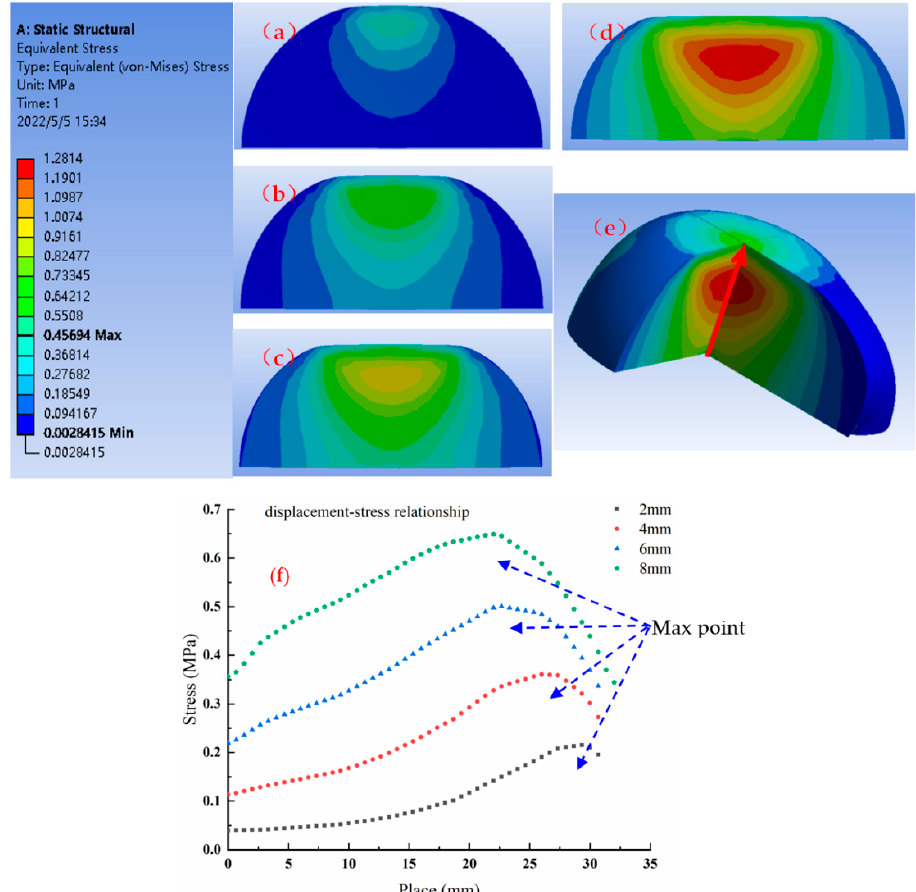
Figure 6. ( a – d ) Stress clouds dissected from the contact point between the apple and the plate parallel to the equatorial plane of the apple, at compression distances of 2, 4, 6, and 8 mm. ( e ) Added monitoring line in the pressure cloud of the apple model at a pressure distance of 8 mm. ( f ) Scatterplot of peak force at different locations and pressing distances. The zero-point x -axis is the bottom of the apple model.